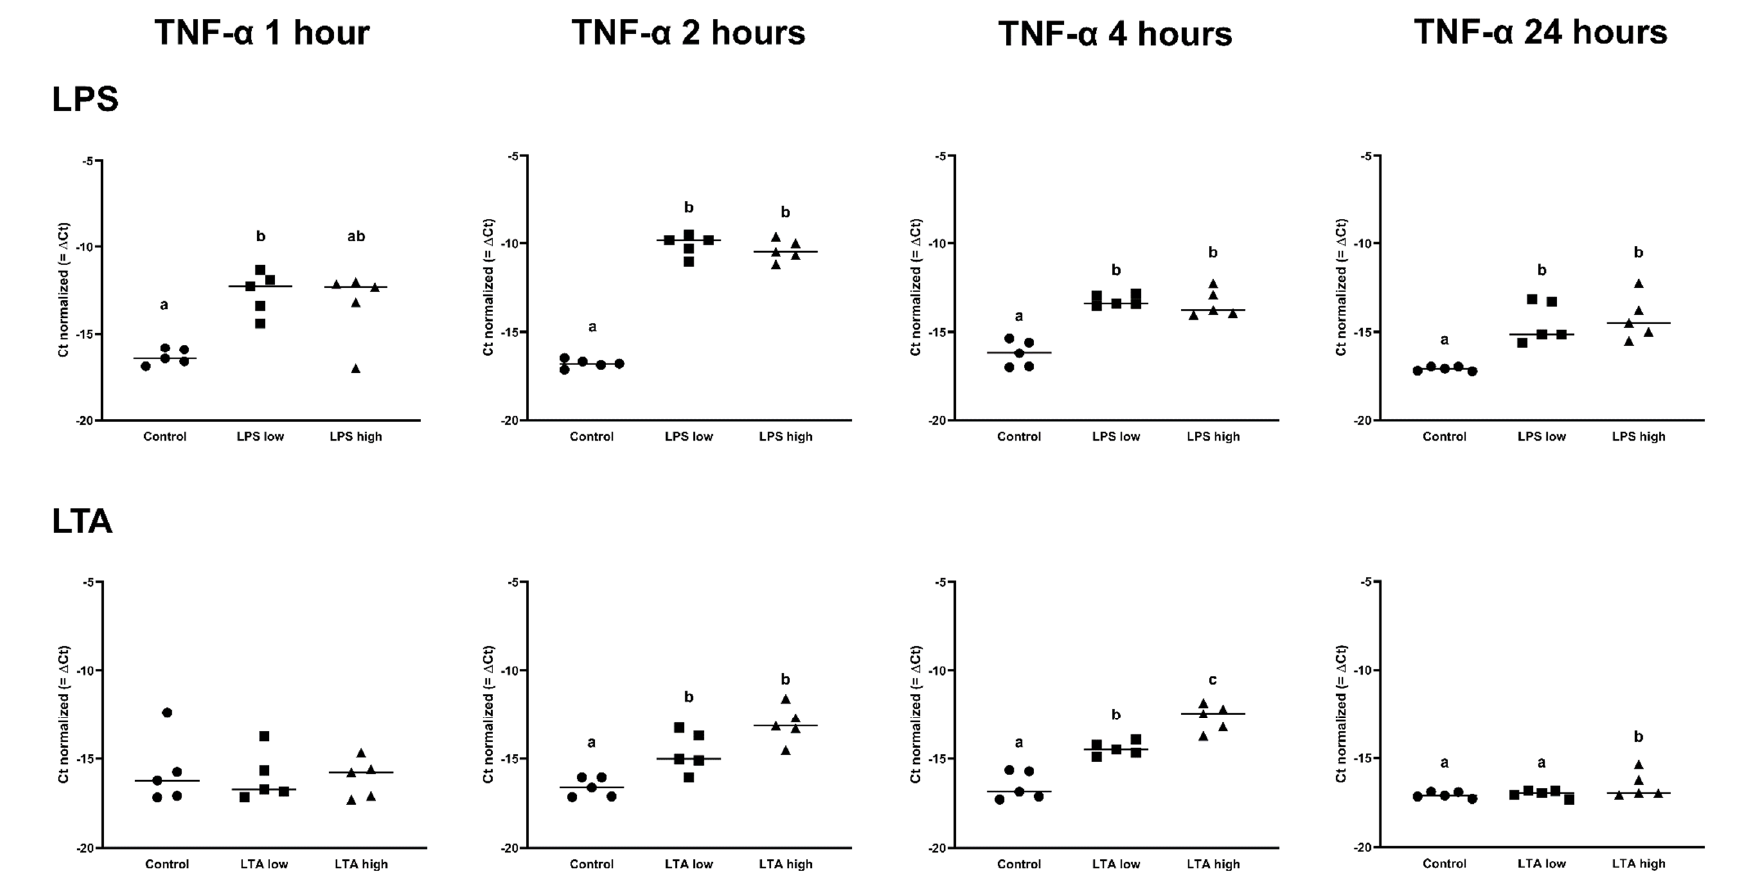
Figure 4. Delta Ct values of TNF-α of RECs treated for 1, 2, 4, and 24 h with 0 µg/mL (Control), 1 µg/mL LPS (LPS low), 10 µg/mL (LPS high), 1 µg/mL LTA (LTA low), and 10 µg/mL LTA (LTA high). a,b,c Superscripts indicate significant differences within 1, 2, 4, and 24 h: p < 0.05. n = 5 independent experiments.